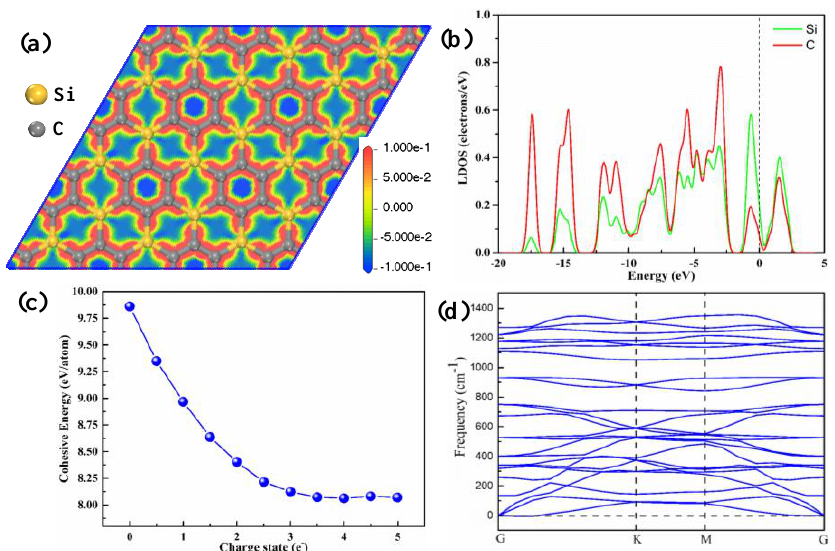
Figure 1. ( a ) Deformation electron density of SiC 3 nanosheet structure (4 × 4), ( b ) LDOS of the Si and C atoms of SiC 3 nanosheet with Fermi level set to 0 eV, ( c ) the cohesive energy of the SiC 3 nanosheet under different negative charge density conditions, and ( d ) the phonon dispersion spectra of SiC 3 nanosheet.